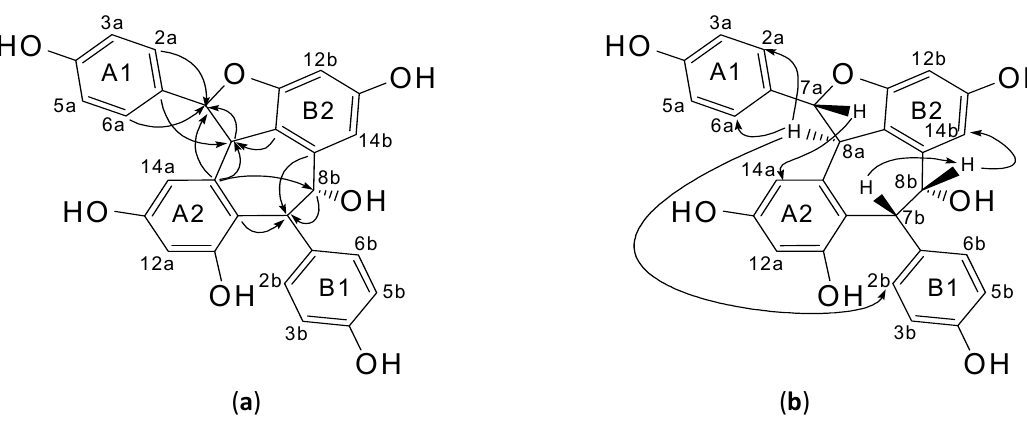
Figure 2. Key HMBC ( a ) and NOE ( b ) correlations for 1